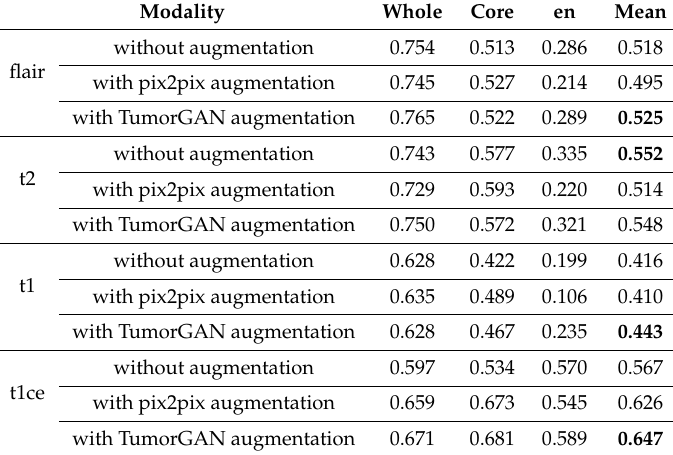
Table 4. Dice score comparison of U-Net trained on single modality “Train”, “Train+Augmentation” and “Train + Pix2pix augmentation”. The best mean dice scores are highlighted